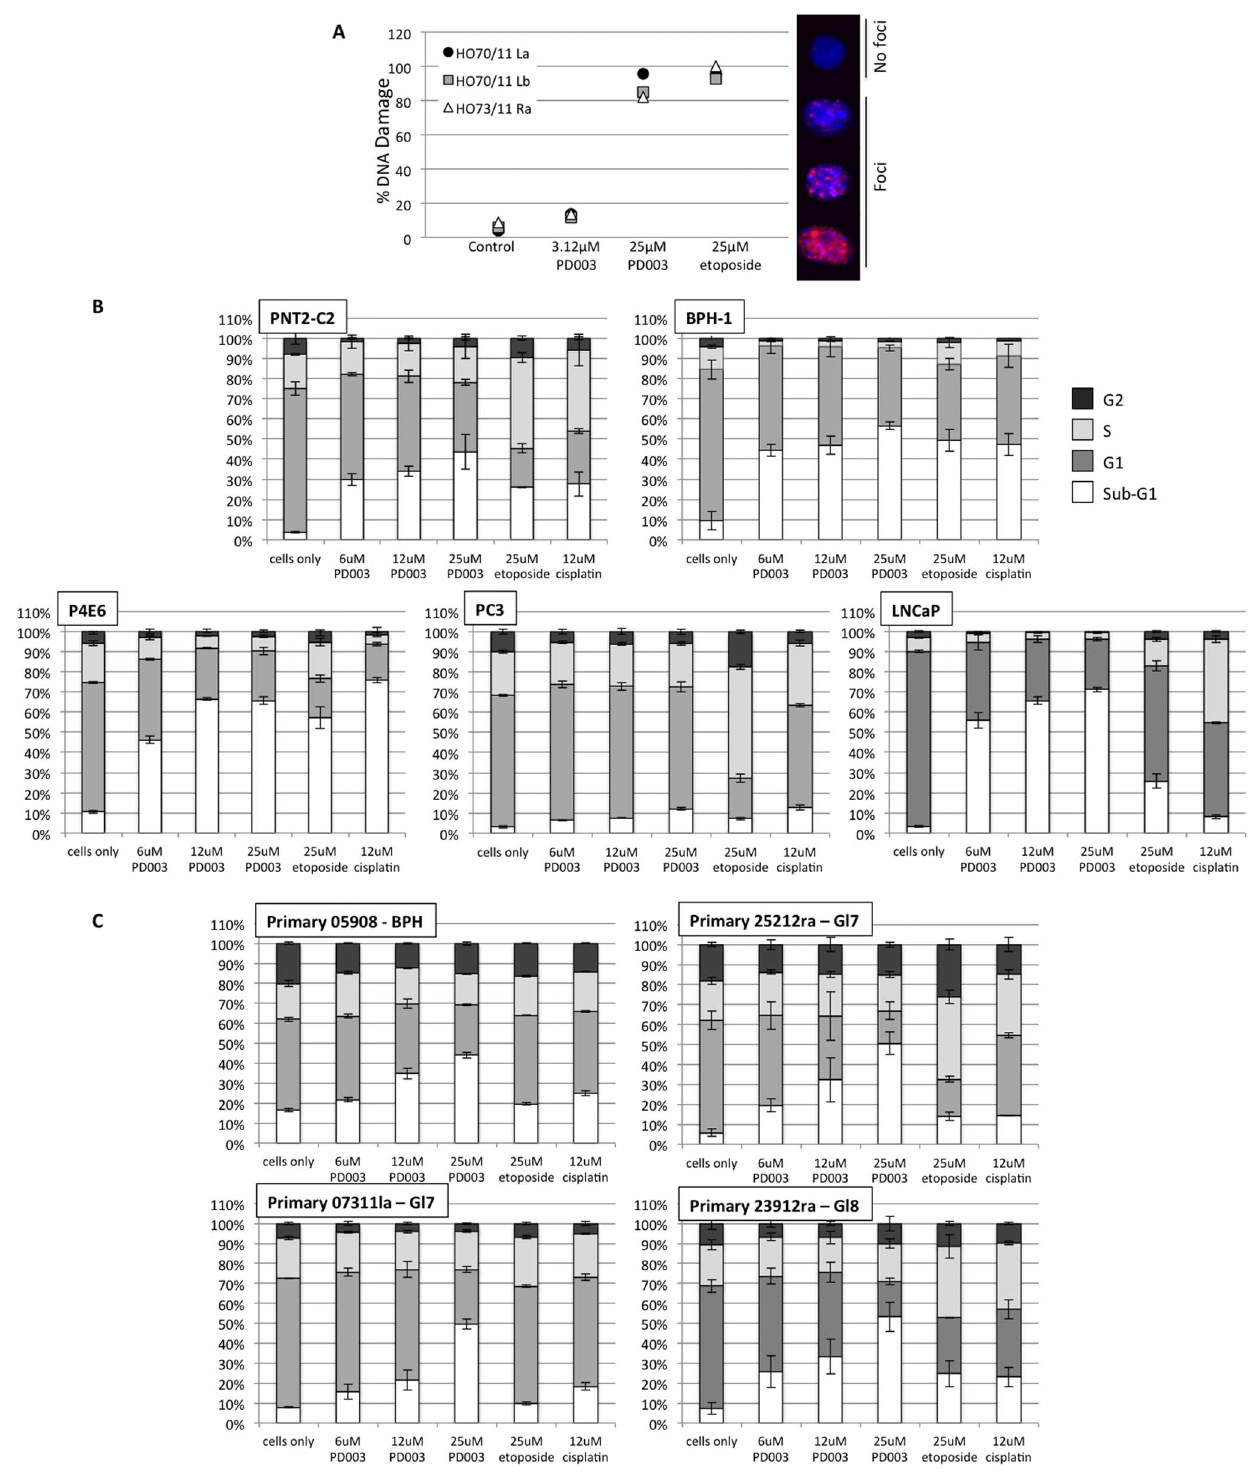
Figure 5. DNA-damaging effect and effect on Cell Cycle Status of Pd complex. (A) Primary cultures isolated from two patients with prostate carcinoma were assessed. Cells were stained and scored for nuclear foci indicative of DNA damage Representative examples of cells negative and positive for nuclear foci are shown. (B) Normal (PNT2-C2) and benign (BPH-1) cell lines, three cancer cell lines (P4E6, PC-3 and LNCaP) and (C) four primary cultures derived from patients with prostate carcinoma were treated with three concentrations of palladium complex or etoposide or cisplatin as control treatments. Cell cycle phase was measured using propidium iodide staining and flow cytometry analysis.